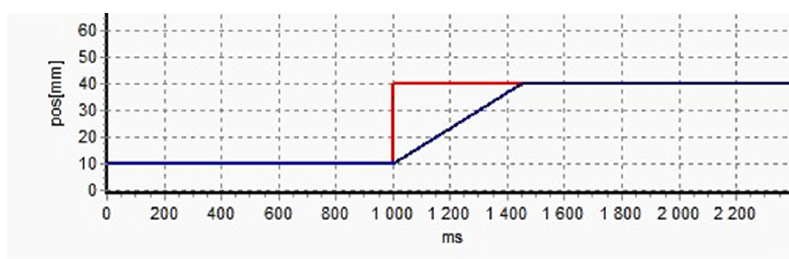
Figure 16. The actuator response to the step input.